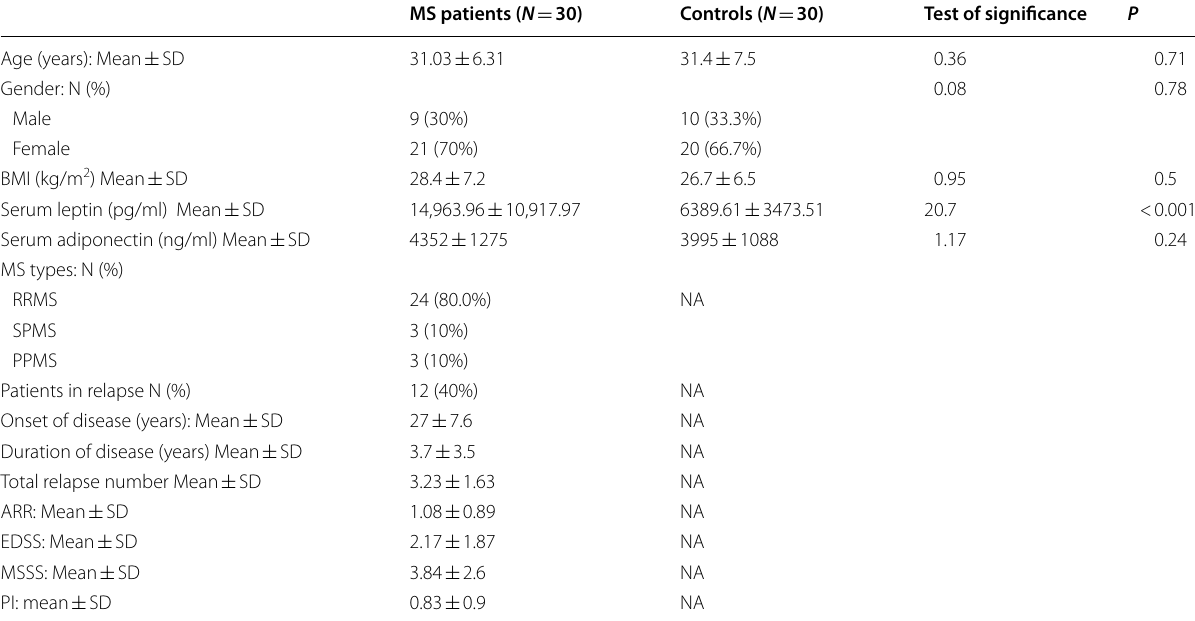
Table 1 Demographic and clinical data of the MS patients and controls